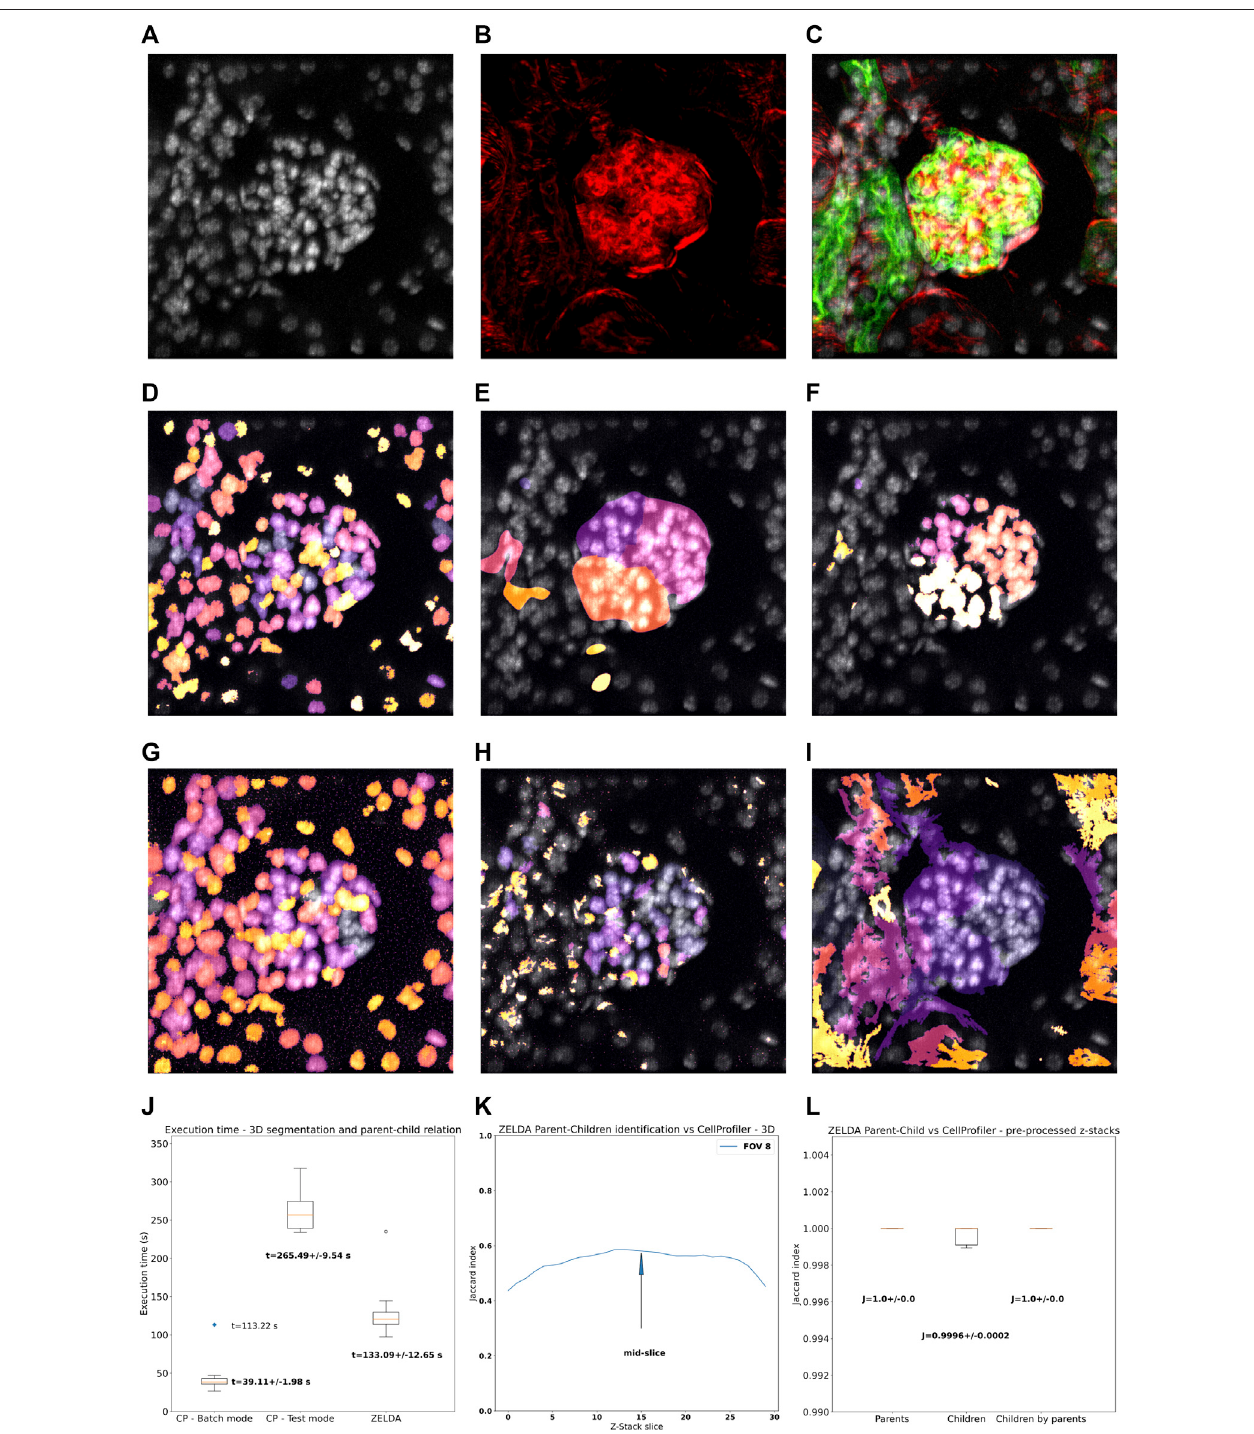
FIGURE 5 | 3D segmentation, “ parent-child ” relation, and execution time of ZELDA compared to CellPro fi ler . Z-stacks of mouse kidney tissue showing glomeruli were used for the benchmark in 3D. (A) DAPI staining used to segment the cell nuclei. (B) Phalloidin used to identify the glomerular structures (C) 3D rendering showing the merge of DAPI (gray), WGA (green), and phalloidin (red). (D) Nuclei, (E) glomerular structures, and (F) masked nuclei (parent-child relation) labelled by ZELDA in 3D. (G) Nuclei, (H) glomerular structures, and (I) masked nuclei (parent-child relation) labelled by CellPro fi ler in 3D (using a pipeline containing only 3D data compatible modules). (J) Execution time for the same work fl ow developed as both CellPro fi ler pipeline and ZELDA protocol, with the goal to segment in 3D and relate parents and children objects. The boxplots represent the distribution of multiple runs analyzing individual FOVs. For CellPro fi ler in batch mode, the CPU time has been